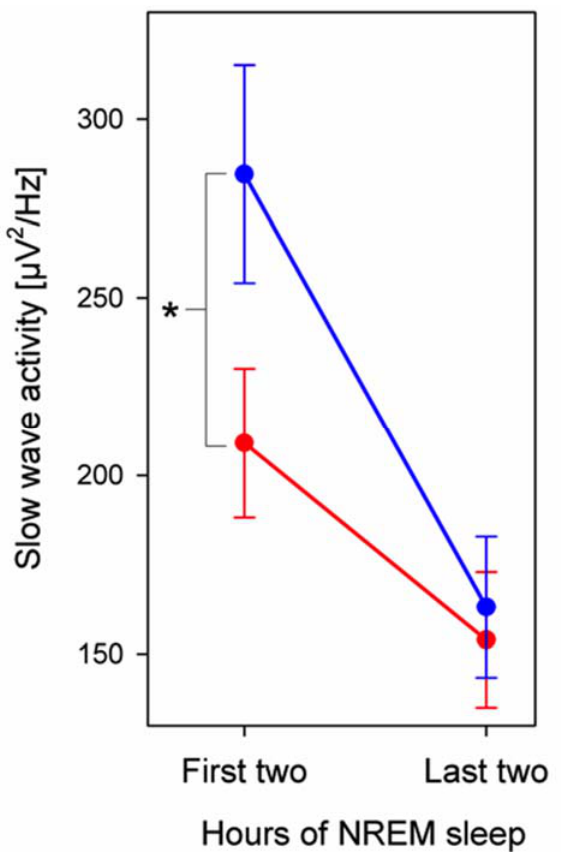
Figure 2. Slow-wave activity (SWA) across the night in caffeine consumers (red, n = 16) and controls (blue, n = 16). SWA (1–4.5 Hz) was averaged across all electrodes (M ± SEM) for the first and last two hours (latest possible artifact-free, common two hours among all subjects) of NREM sleep stages N2–3. The asterisk indicates a significant difference between caffeine consumers and controls in the first two hours of NREM sleep ( p < 0.05, two-tailed, unpaired Student’s t